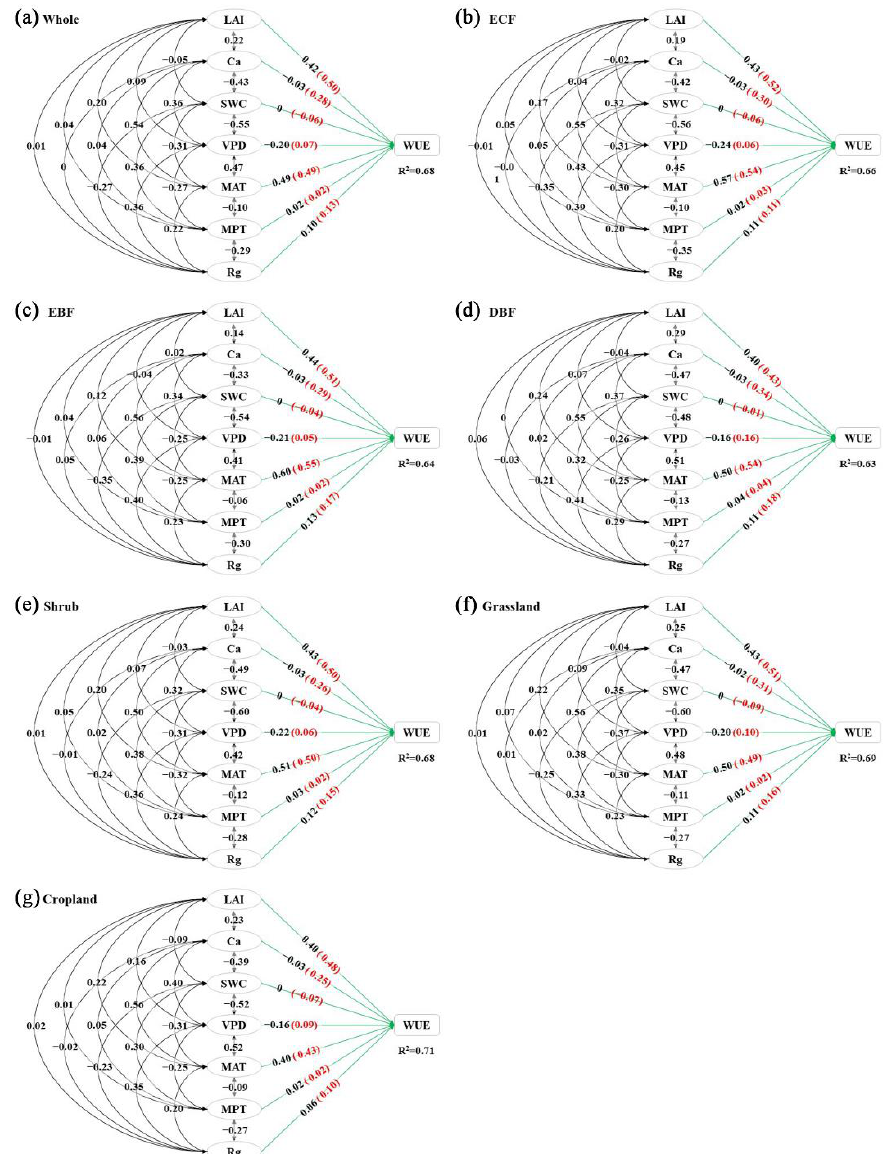
Figure 3. Path diagrams between climate variables (average annual temperature (MAT), annual accumulated precipitation (MAP), and annual solar radiation (Rg), soil water content (SWC), vapor pressure deficit (VPD)), leaf area index (LAI), and elevated atmospheric CO 2 (Ca), and WUE in the study area. Numbers on arrows between each factor and WUE represent direct effects, and numbers in parentheses represent total effects. Numbers on arrows between every two factors represent cor- relation coefficients. ( a ) Whole of the study area, ( b ) ECF, ( c ) EBF, ( d ) DBF, ( e ) shrub, ( f ) grassland, ( g ) cropland. R 2 values beside the response variables represent the variance explained by the envi- ronmental factors and the constructed relationships. ( α indicates direct effect and β indicates total effect.)